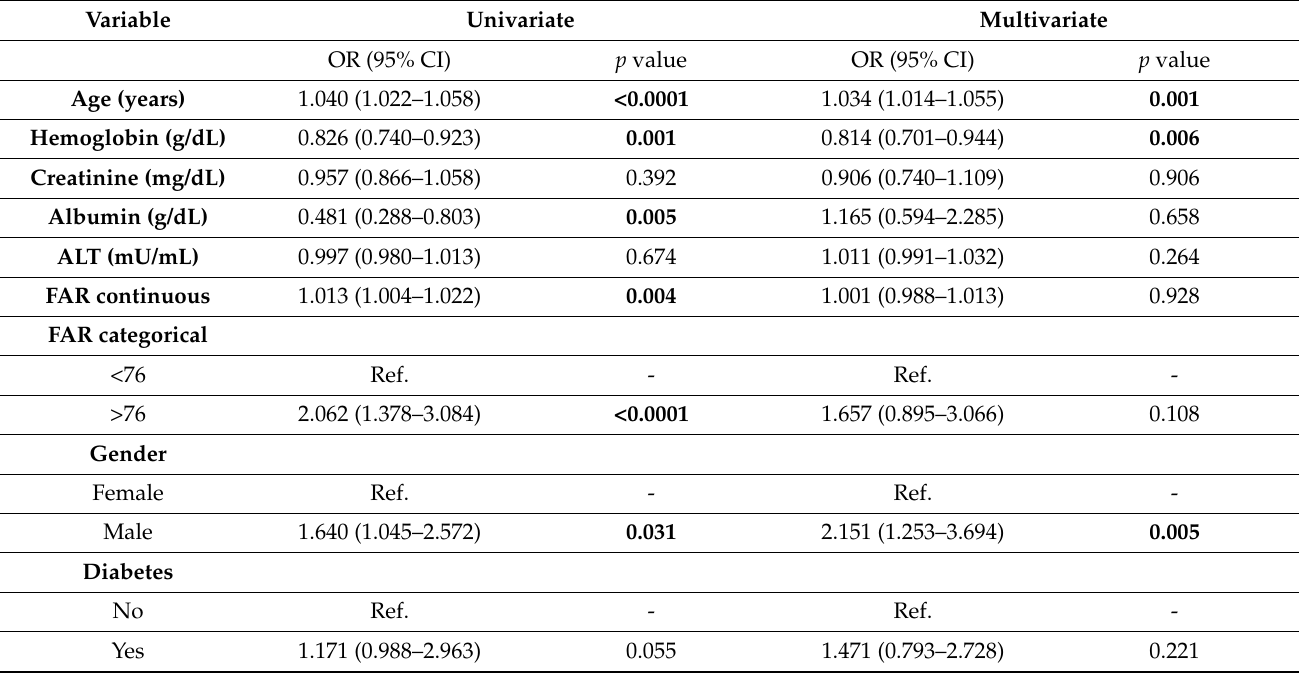
Table 3. Univariate and multivariate logistic regression